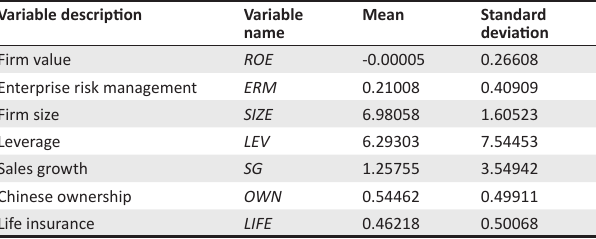
TABLE 1: Mean and standard deviation for each variable. Variable description